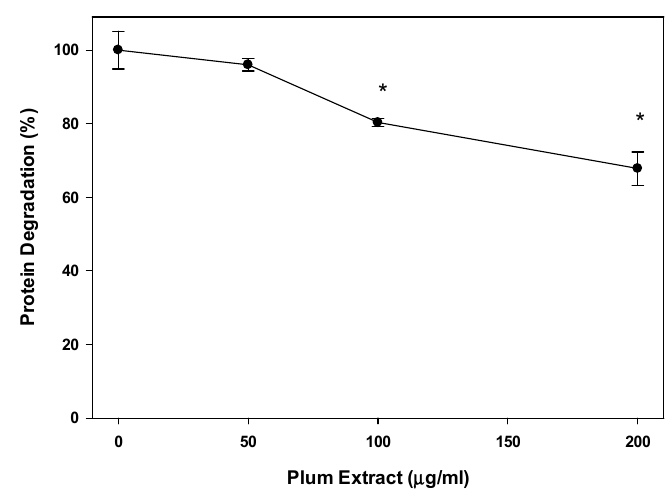
Figure 4. The effect of plum extract on myotubule protein degradation. Proteolysis was induced by 48 h-serum starvation in the presence or absence of plum extract, and monitored by release of radioactive tyrosine from pre-labelled cells. Data were computed as cpm/mg of proteins and then % change over control was calculated. The data were expressed as mean ± SD for at least three experiments. All comparisons were made to control (untreated cells) using one-way ANOVA; significant differences are reported at * p < 0.05.